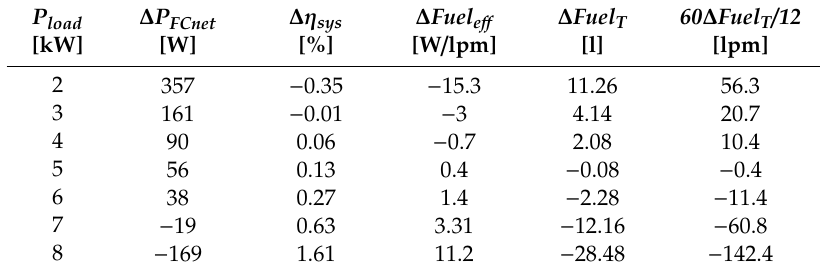
Table 2. The gaps in performance indicators for the Air-LFW and sFF strategies (P RES = 0). P load ∆ P FCnet